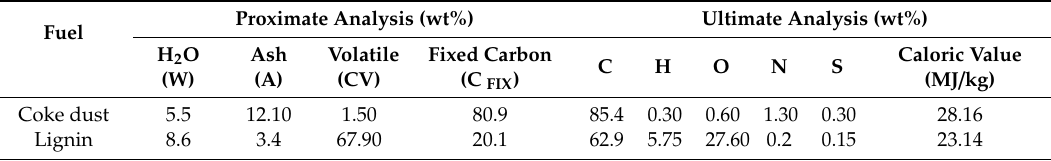
Table 3. Chemical analysis and energy content of